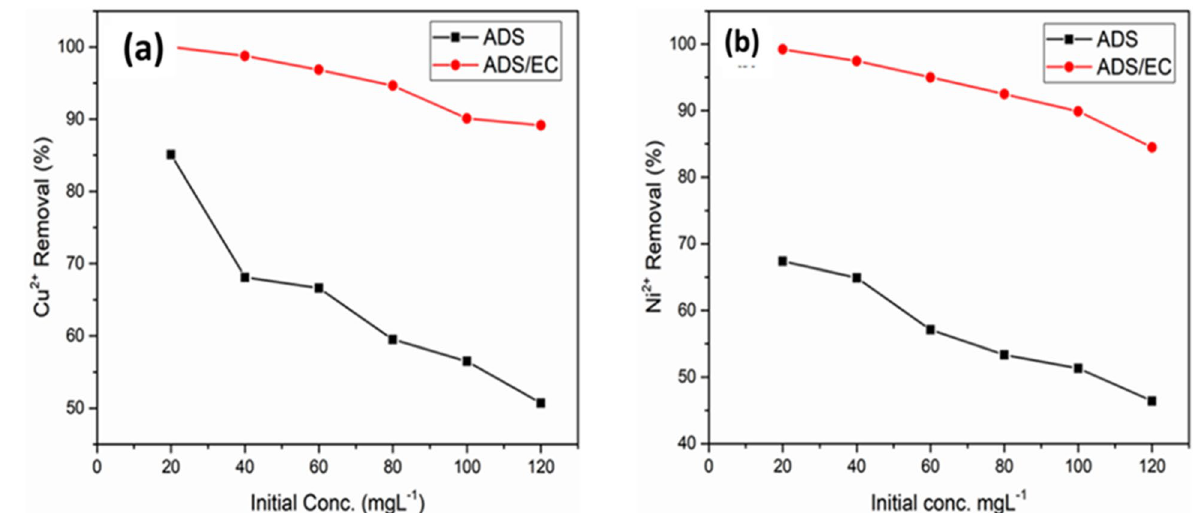
Figure 7. Effect of Initial Concentration on ( a ) Cu 2+ and ( b ) Ni 2+ removal of the synthesized wastewater during the ADS and ADS/EC coupling processes (AGWTR = 1 g L −1 and Current density = 1.19 mA cm −2